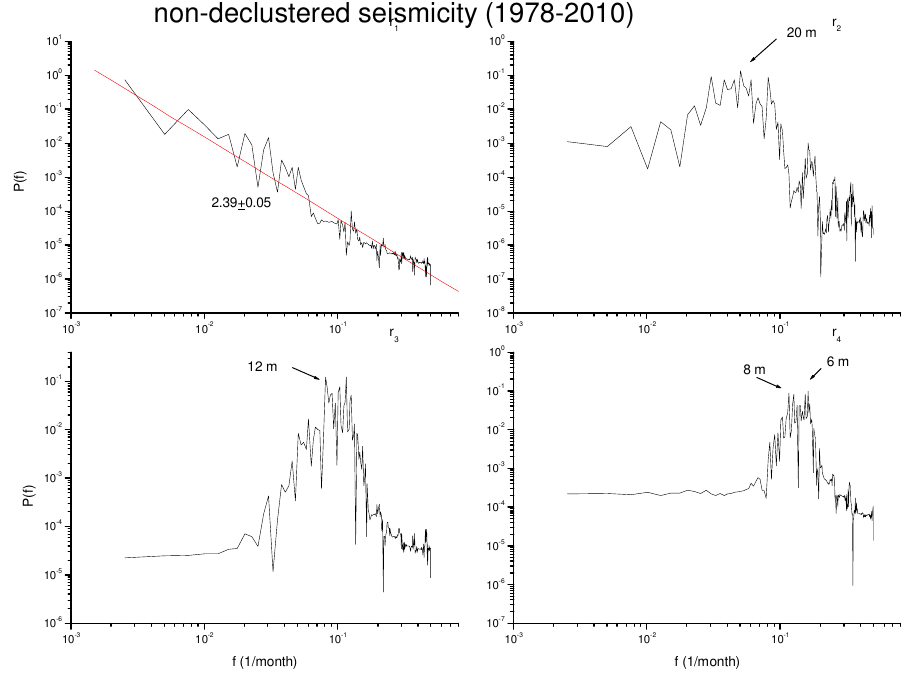
Fig. 9. Power spectrum of the first four reconstructed components of the non-declustered catalogue from 1978 to 2010.